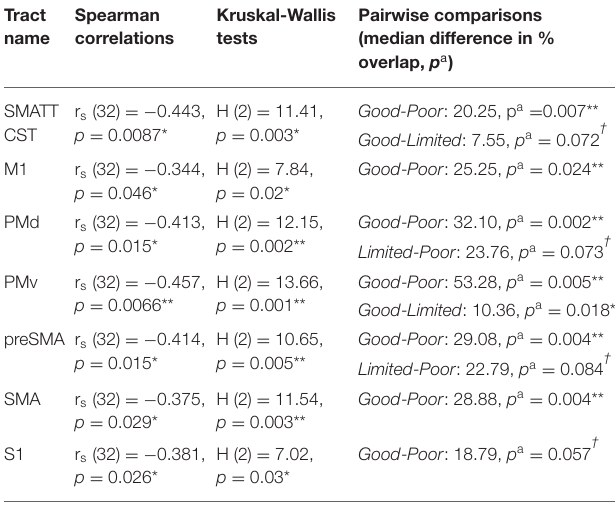
TABLE 2 | SMATT tracts correlate with E-ARAT scores and distinguish between PUE outcome groups ( n = 34). Tract Spearman Kruskal-Wallis name correlations